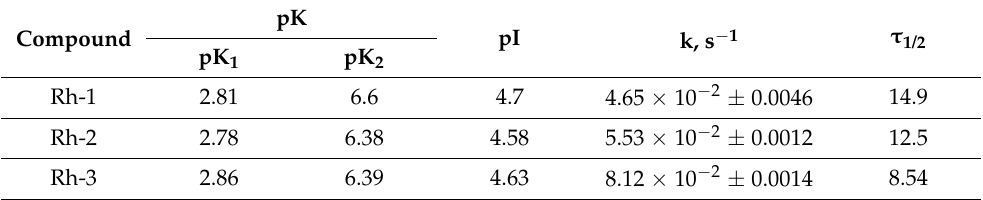
Figure 2. Plot of pH vs. V NaOH and first derivatives graphics of 20 µmoL of Rh-1, Rh-2, and Rh-3, respectively. Table 1. Physicochemical characterization of Rh-1, Rh-2, and